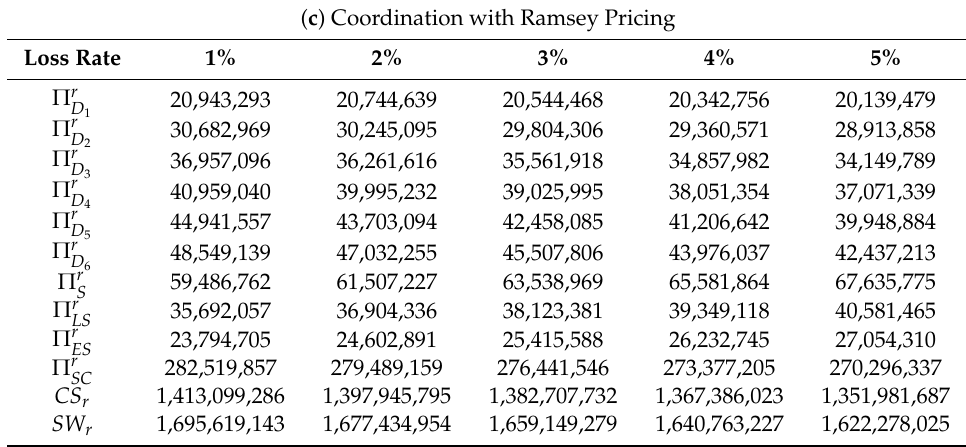
Table 7. Cont . ( c ) Coordination with Ramsey Pricing